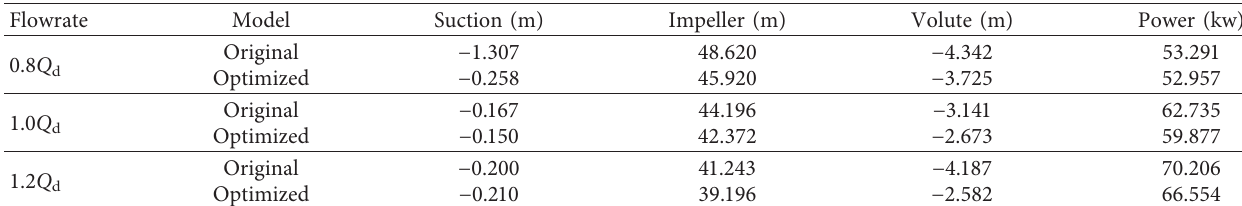
Table 14: Hydraulic head distribution of optimized and original